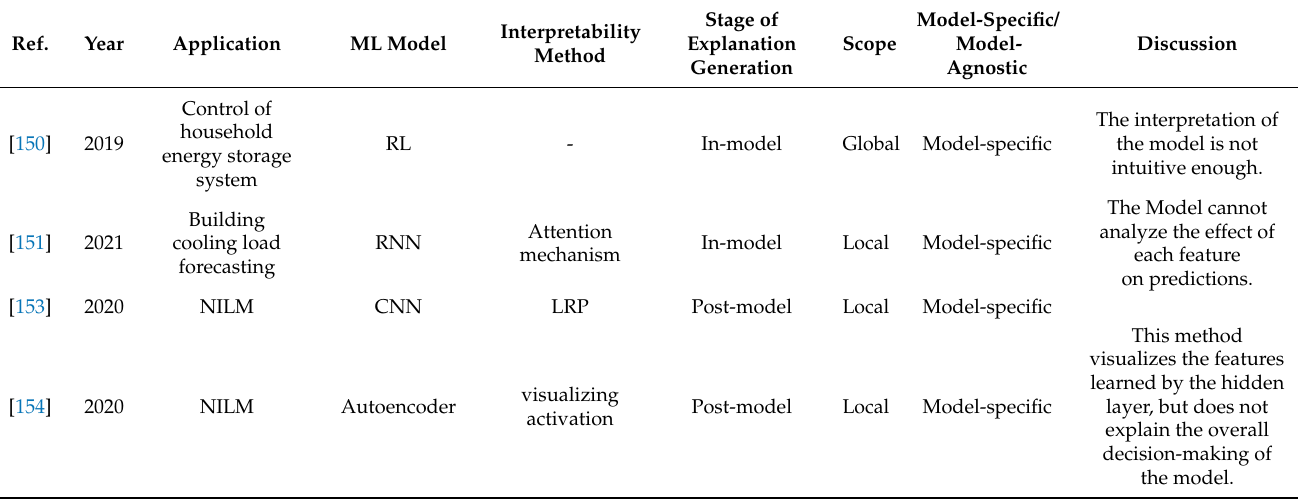
Table 5. Summary of interpretable ML for power system